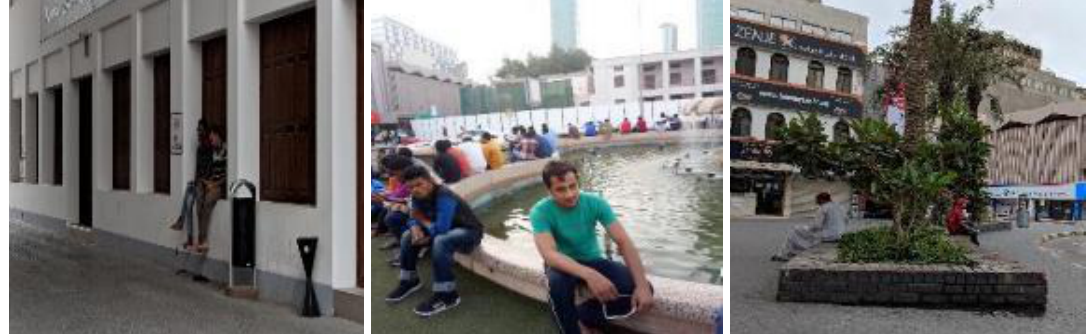
Figure 17. Mal-allocating for sitting areas